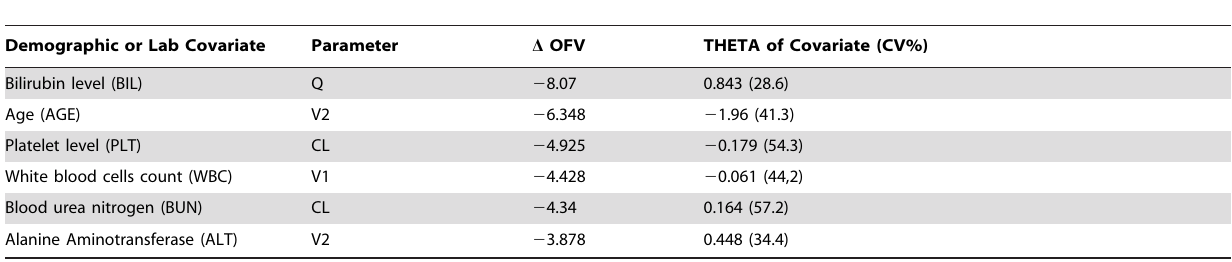
Table 5. Six significant covariate-parameter correlations after inclusion of single demographic or lab covariates.